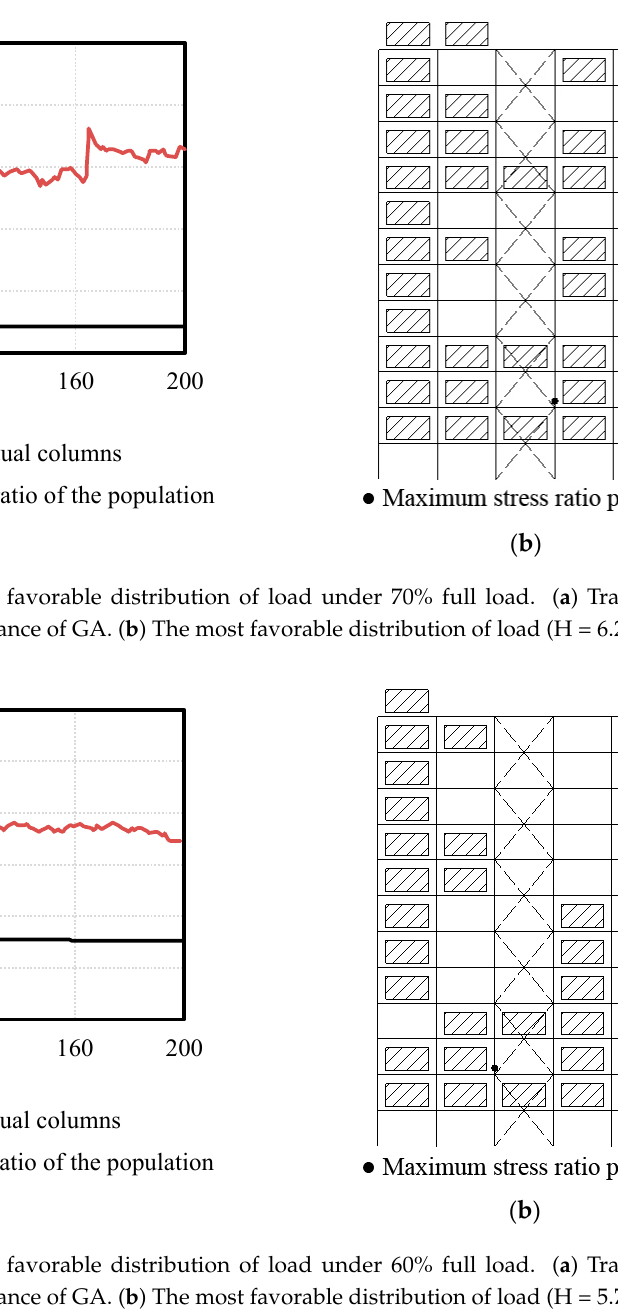
Table 5. Parameters related to the most unfavorable distribution patterns of the optimized loads.